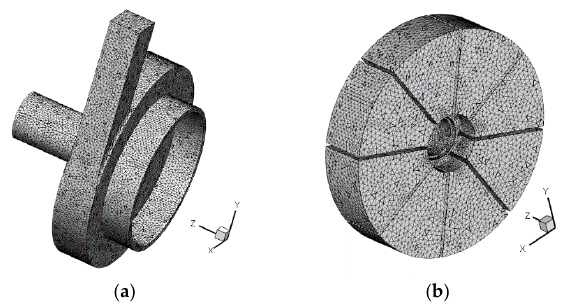
Figure 4. Simulation grids: ( a ) Volute; ( b ) Impeller.